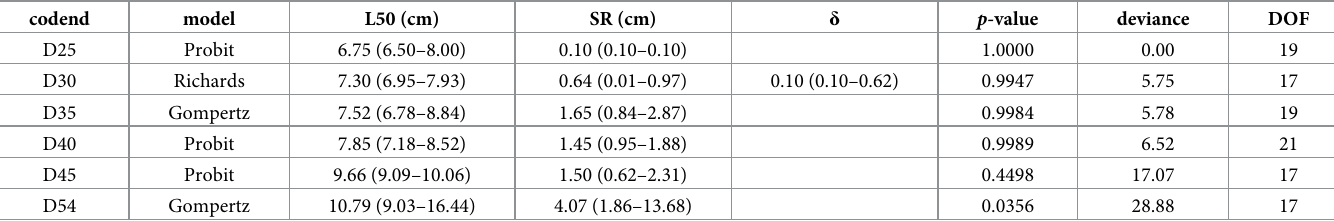
Table 4. Selectivity parameters and fit statistics obtained from the selected models for the tested codends. codend